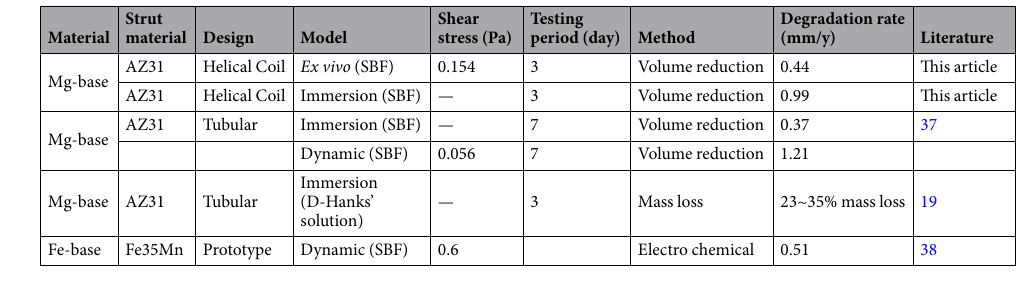
Table 3. Comparison of the bioresorbable metallic